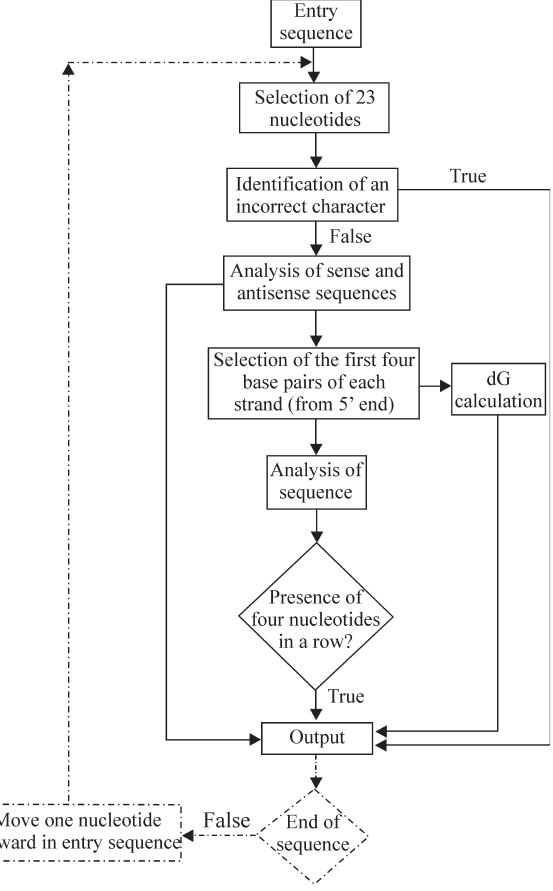
Figure 1 - Strand Analysis (SA) flowchart. The SA software has two dif- ferent modes: ‘oligo analysis’ for 23-mer pre-selected targets (continuous lines only) and ‘sequence analysis’ for complete transcript scanning (all